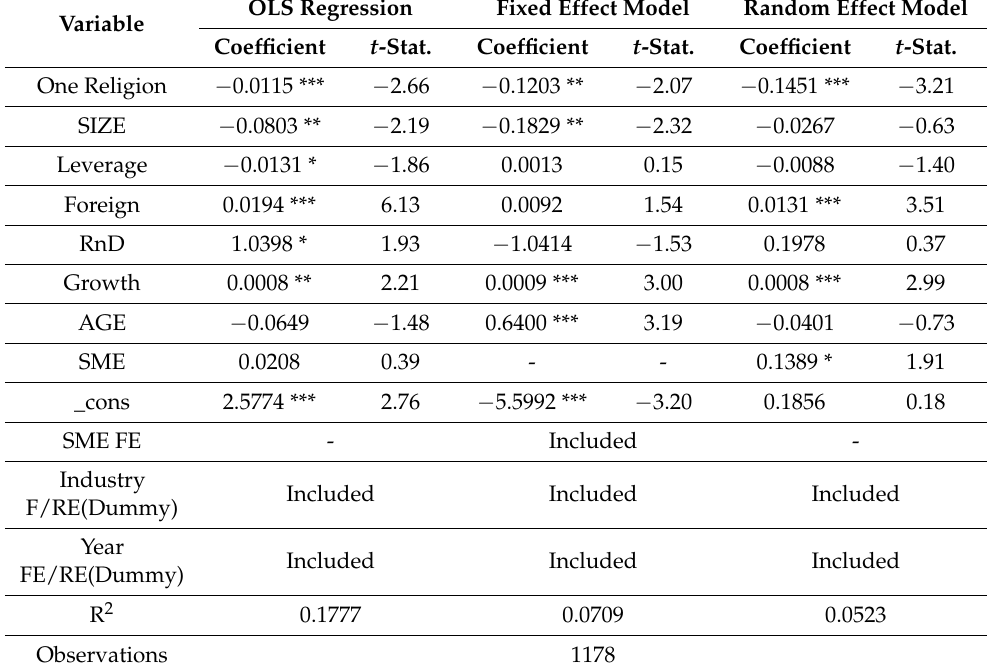
Table 5. Additional Test (one religion